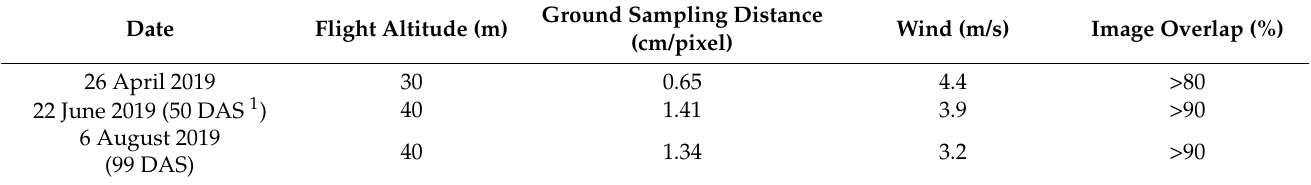
Table 4. The campaign of the unmanned aerial vehicle used in this